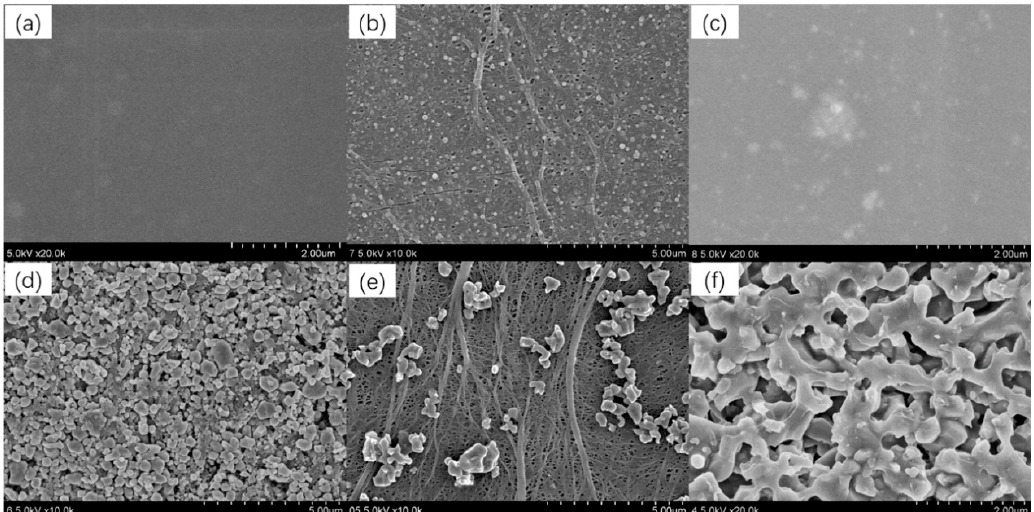
Figure 4. SEM images of ( a ) bare tape; ( b ) the SiO 2.01 C 0.23 H x -coated PE separator after peel-off test; ( c ) corresponding tape surface to ( b ); ( d ) the Al 2 O 3 particle-coated PE separator; ( e ) the Al 2 O 3 particle-coated PE separator after peel-off test; ( f ) corresponding tape surface to ( e ).